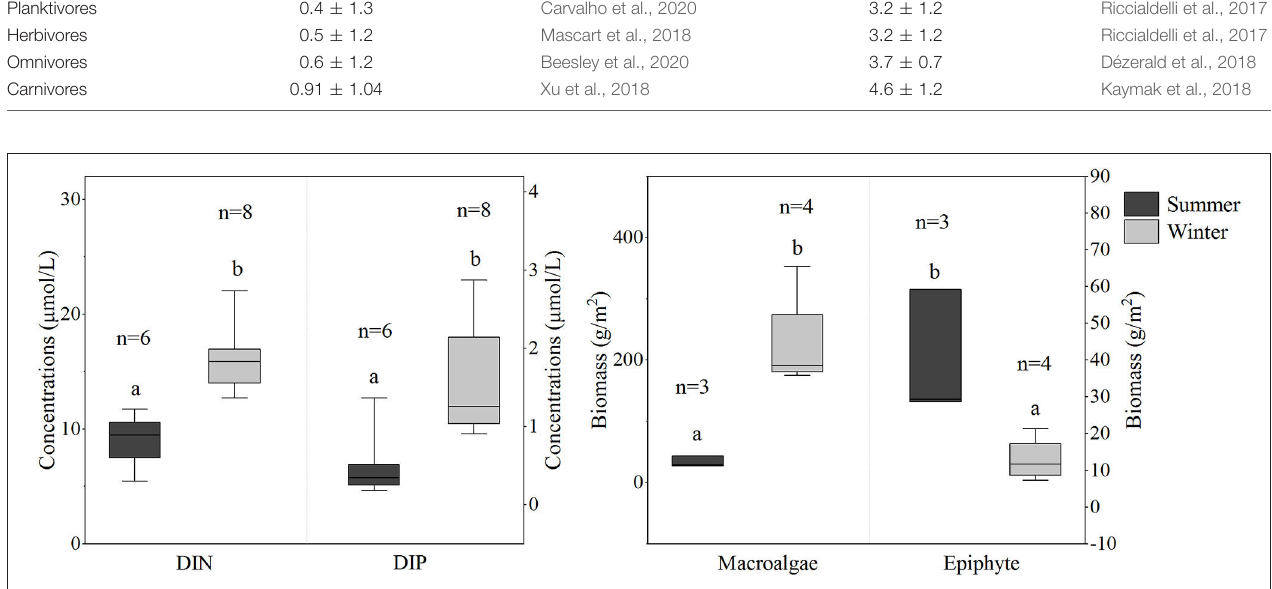
FIGURE 2 | Concentrations of dissolved inorganic nitrogen (DIN) and dissolved inorganic phosphate (DIP), and biomass of macroalgae and epiphytes in summer and winter in Xincun bay meadow. Values are mean ± standard error (SE). The lower case letters (a and b) over the bars indicate significant differences between seasons ( p < 0.05). The lower case letter (n) represents sample size. The detailed statistical analysis results are shown in Supplementary Tables 2,3 .